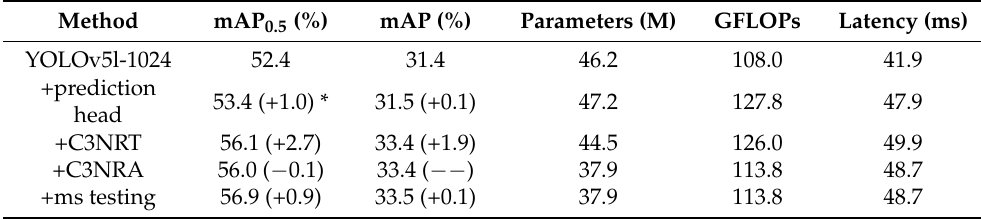
Table 4. Results of ablation